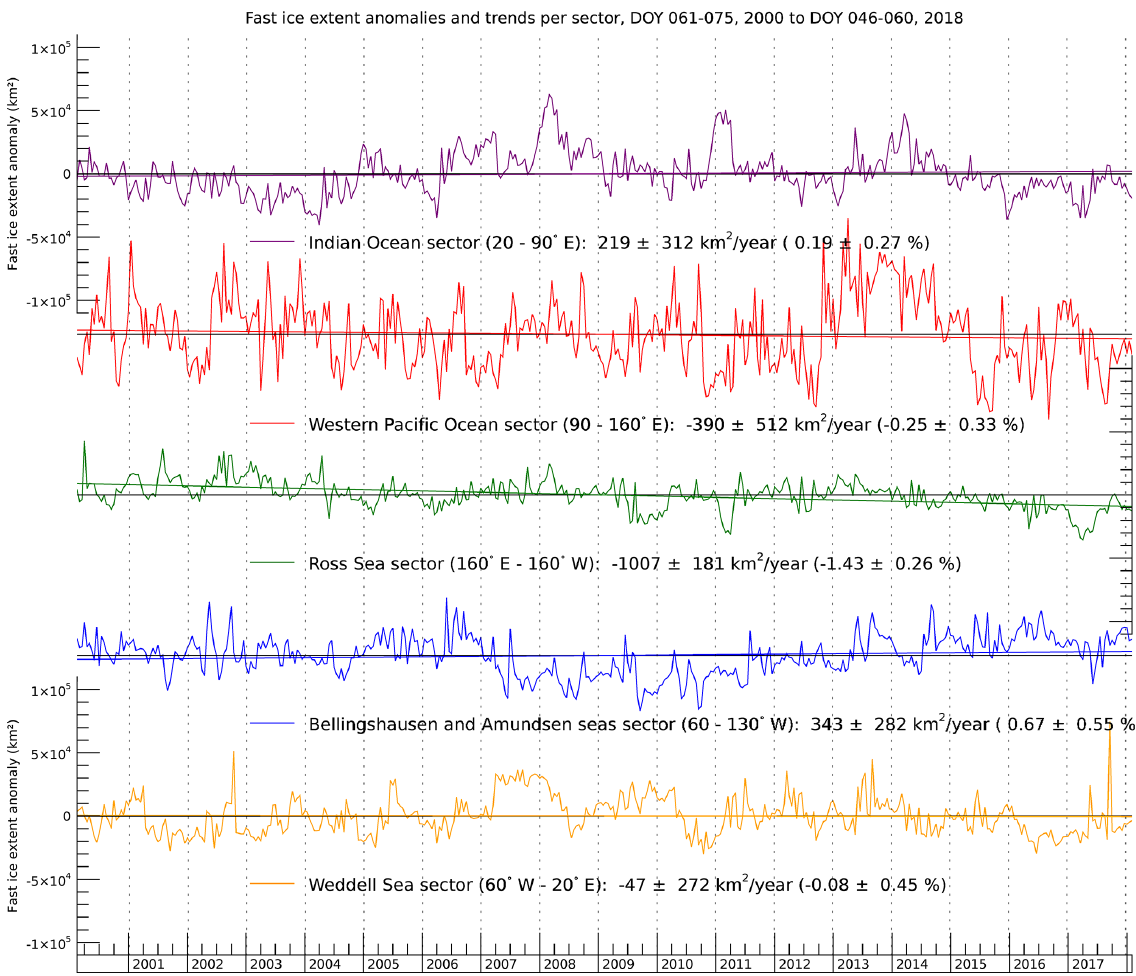
Figure A1. Fast-ice extent anomaly time series for the 18-year period. Only the Bellingshausen and Amundsen Sea sector and the Ross Sea sector show significant